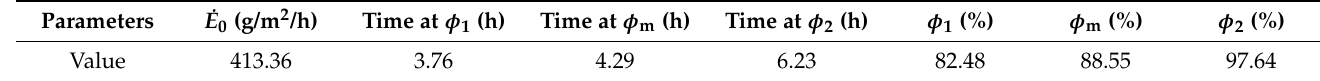
Table 3. Key drying parameters of bitumen emulsion